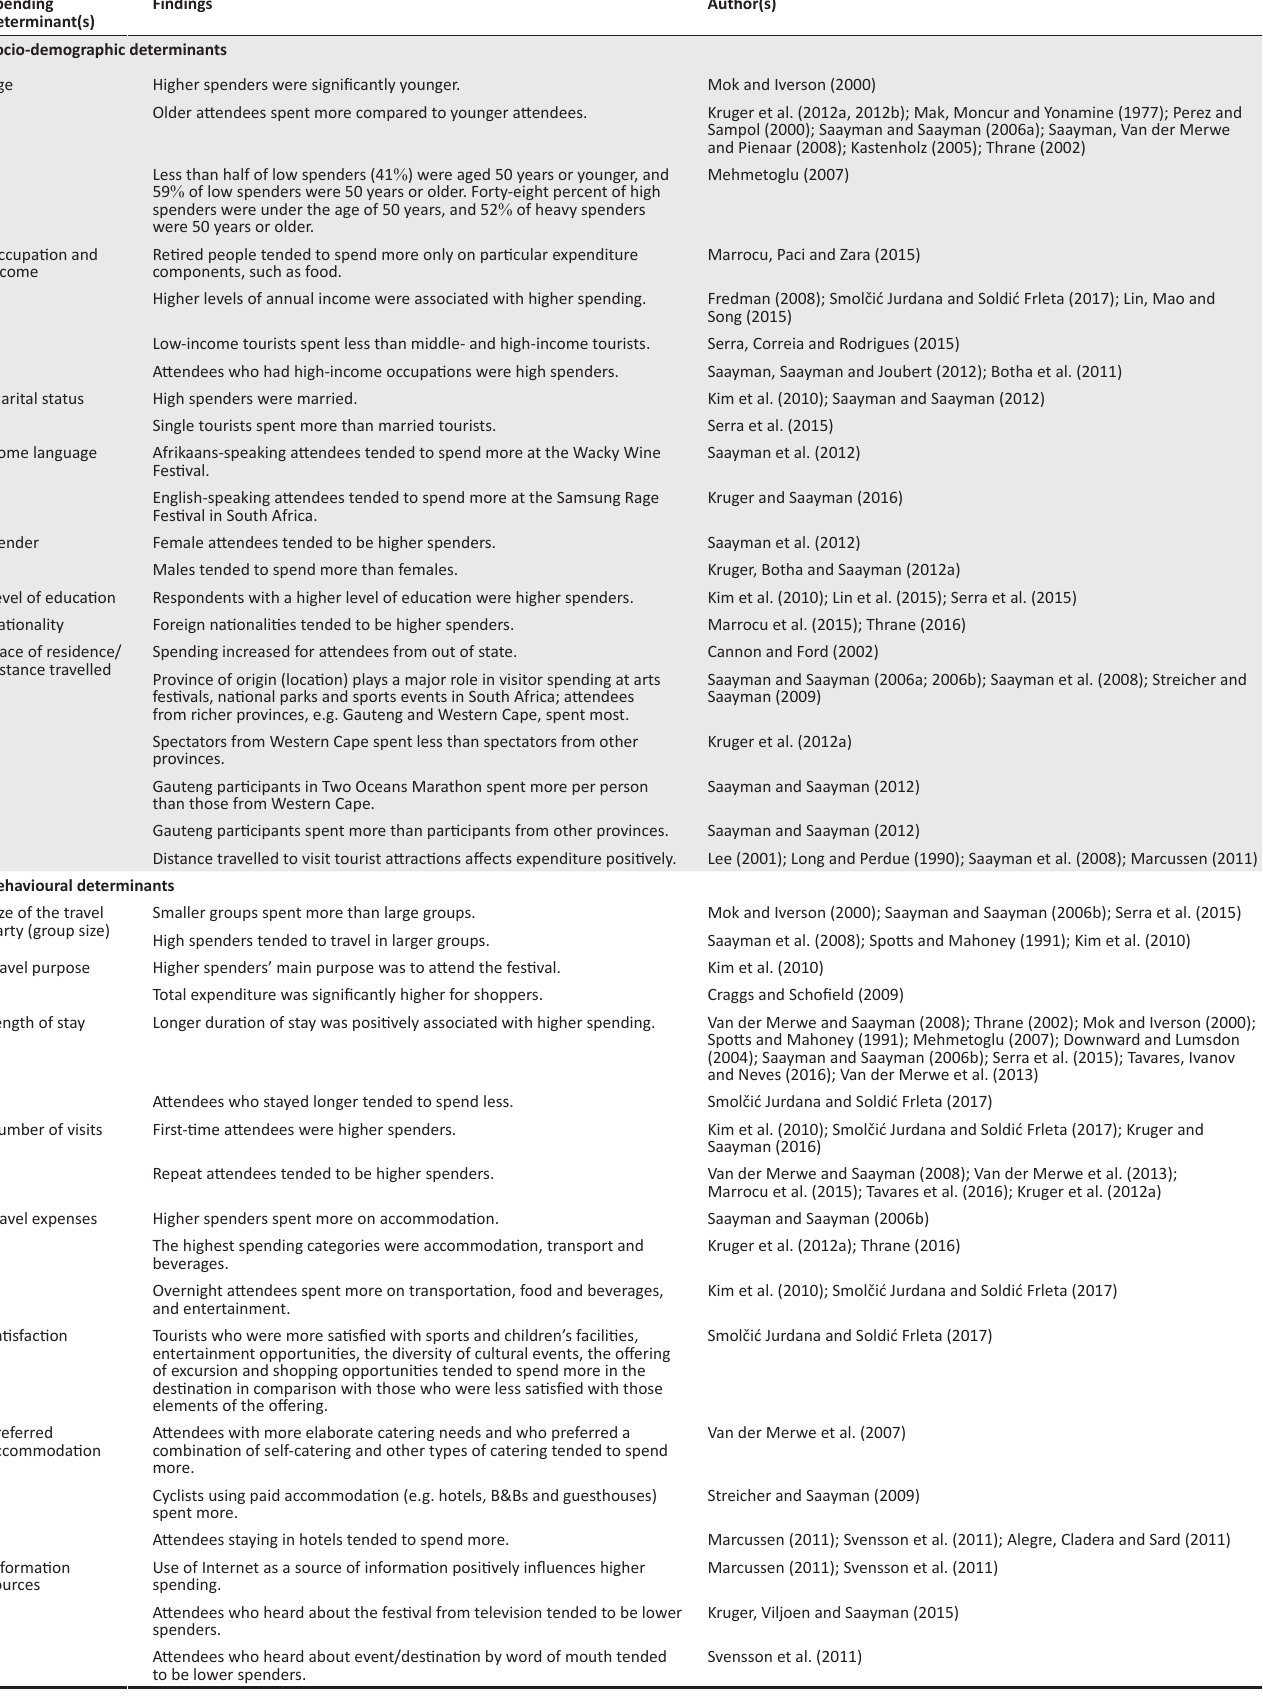
TABLE 1: Determinants of attendee spending as identified in the previous research. Spending